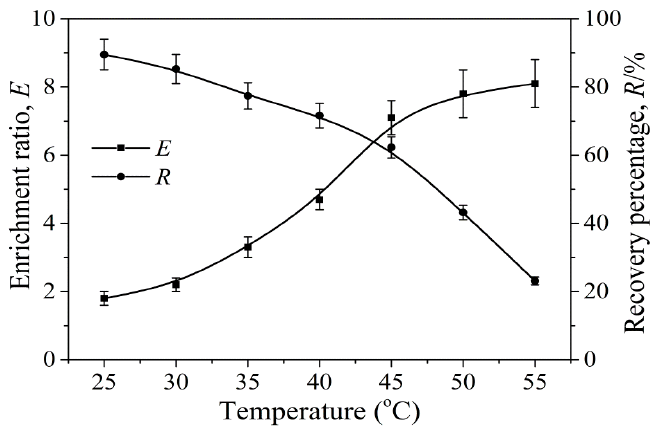
Figure 6. E ff ects of temperature on enrichment ratio and recovery percentage of total Figure 6. Effects of temperature on enrichment ratio and recovery percentage of total anthraquinones.